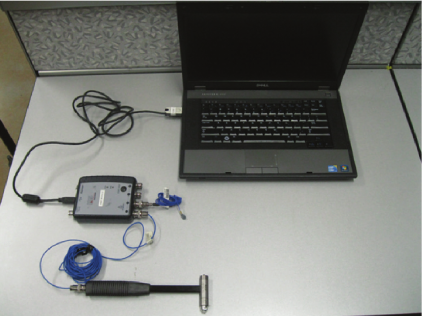
Figure 3: Spindle model.